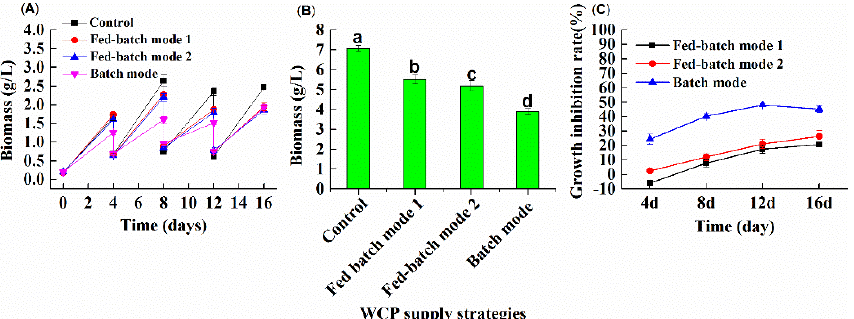
Figure 7. Effects of caprolactam wastewater supply modes on the growth of Arthrospira platensis . ( A ) Growth curves, ( B ) final biomass (g/L), and ( C ) Inhibition rate over time. Error bars represent standard deviation ( n = 3). Data with different letters indicate significant differences ( p < 0.05) between the control and treatments.